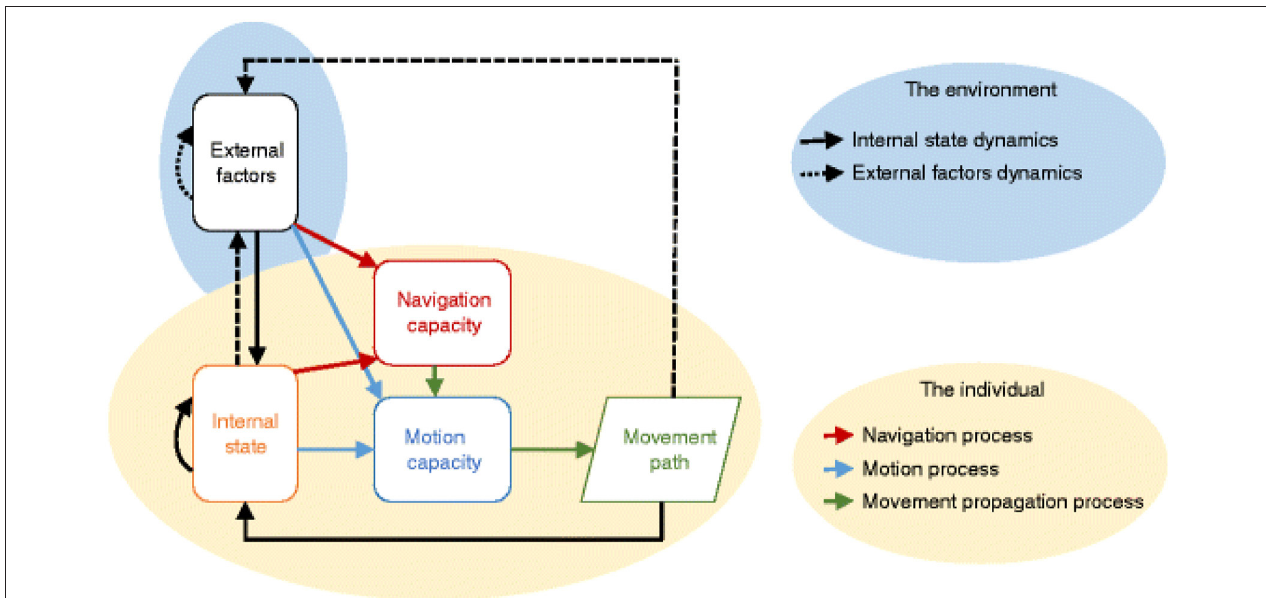
FIGURE 2 | Schematic illustrating the major components influencing animal movement, all of which can be represented within an ABM (Baguette et al.,